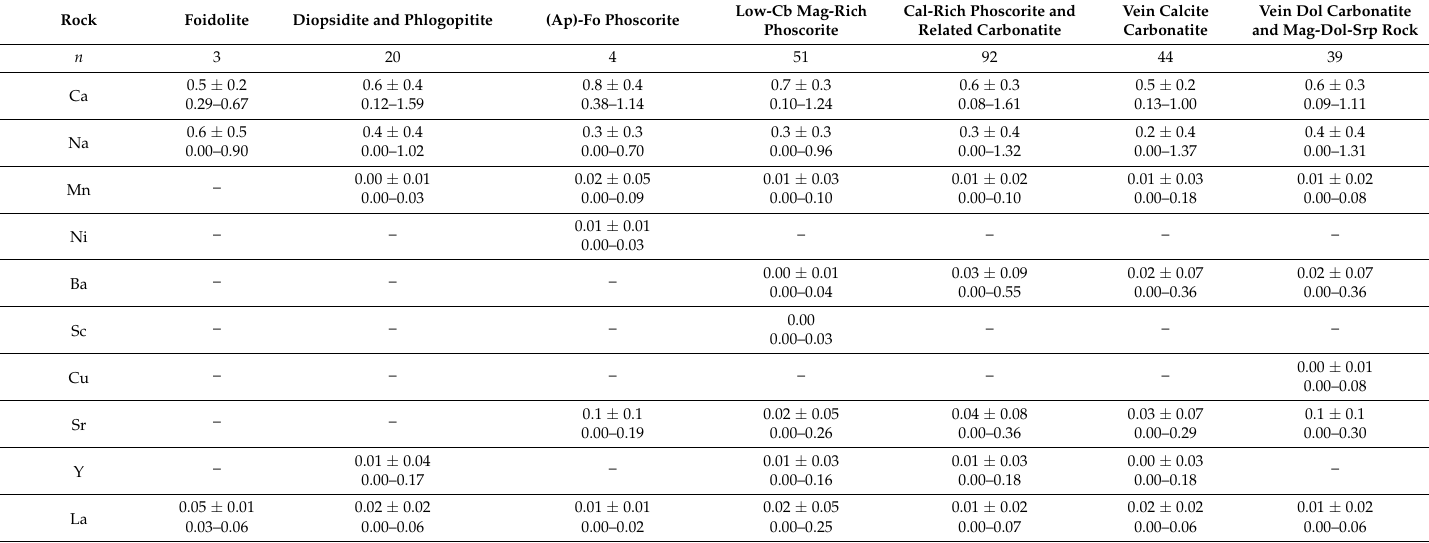
Table 4. The PSM mean composition in rocks of the Kovdor massif (mean ± standard deviation (SD)/min–max, apfu